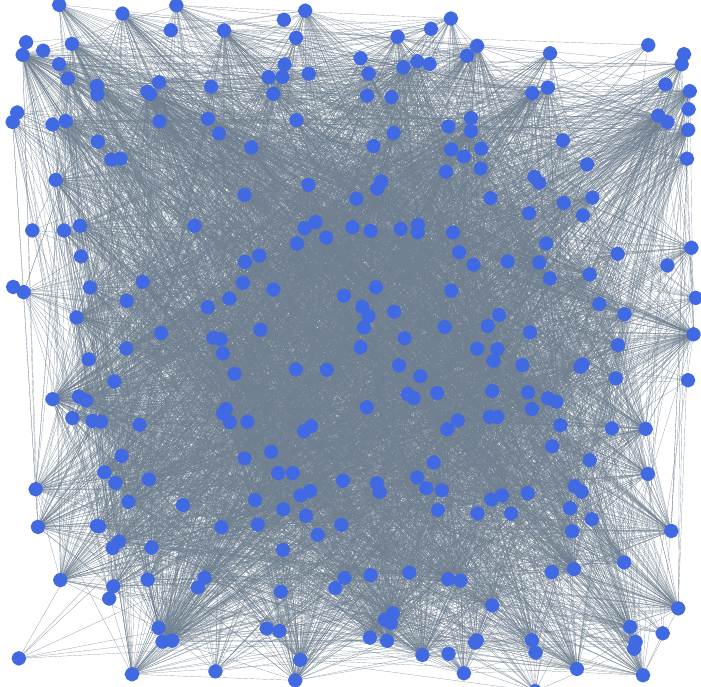
Figure 3. Intersection graph G = ( V , E ) considered, where V (blue nodes) is the set of routes and the (grey) edges in E connect two of those routes when they